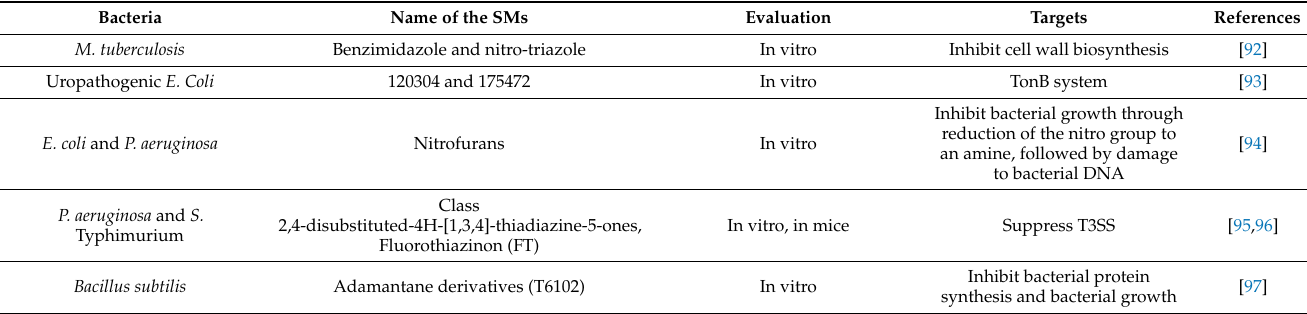
Table 1. Identified SMs against different pathogens and their potential